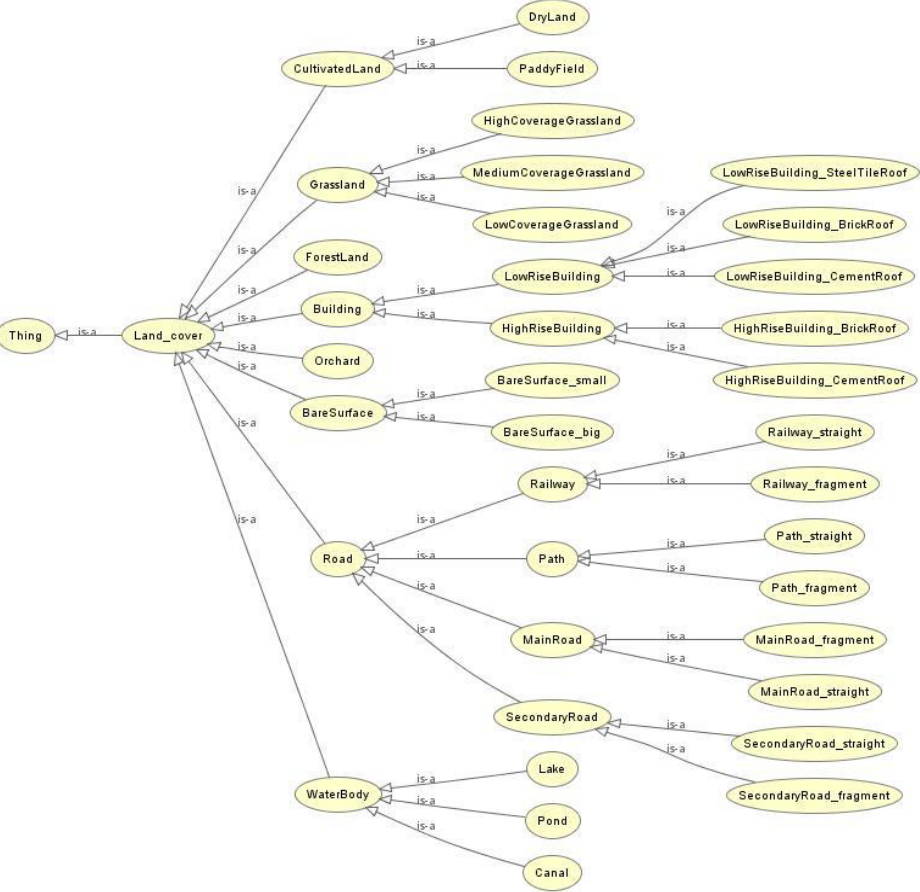
Figure 1. Hierarchy of land cover ontology. According to the China Fundamental Geographic Information Category, land cover classes are selected for the land cover ontology. Land cover classes have the relationship of “is-a” in the ontology hierarchy.